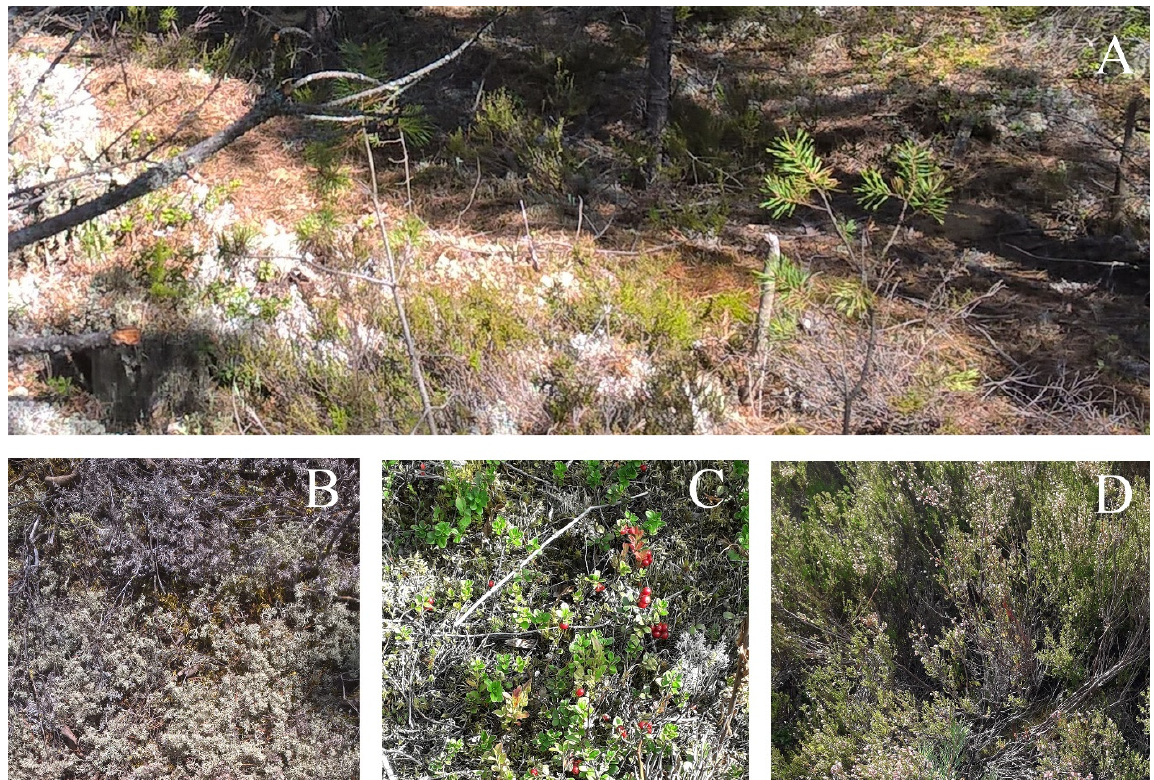
Figure 2. Ground cover of the study area: Overview image ( A ); Cladonia rangiferina ( B ); Vaccínium vítis-idaéa ( C ); Calluna vulgaris ( D ).